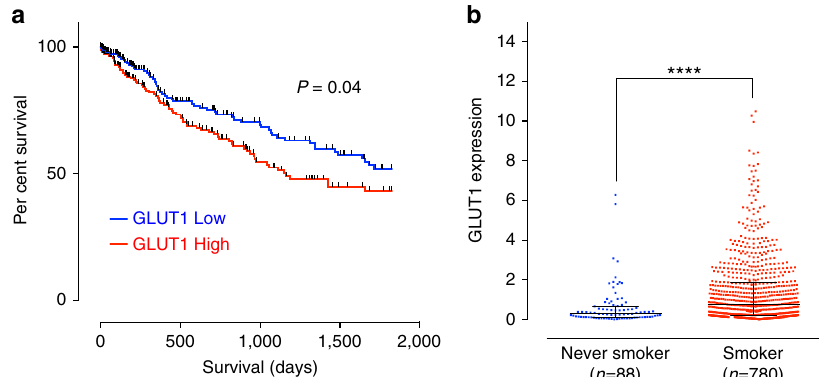
Figure 8 | High GLUT1 expression is associated with poor prognosis. ( a ) Kaplan–Meier 5-year survival analysis comparing GLUT1 high and low expressing patients in the TCGA lung SqCC cohort. GLUT1 high and low groups were separated by the median expression. Significance was determined with log-rank test. P ¼ 0.04; HR, 1.34. ( b ) Comparison of GLUT1 expression (normalized TPM) in patients with smoking history in TCGA NSCLC cohort. Each dot represents one patient ( n ¼ 1018). Error bars represent the median ± interquartile range. Mann–Whitney u -test. **** P o